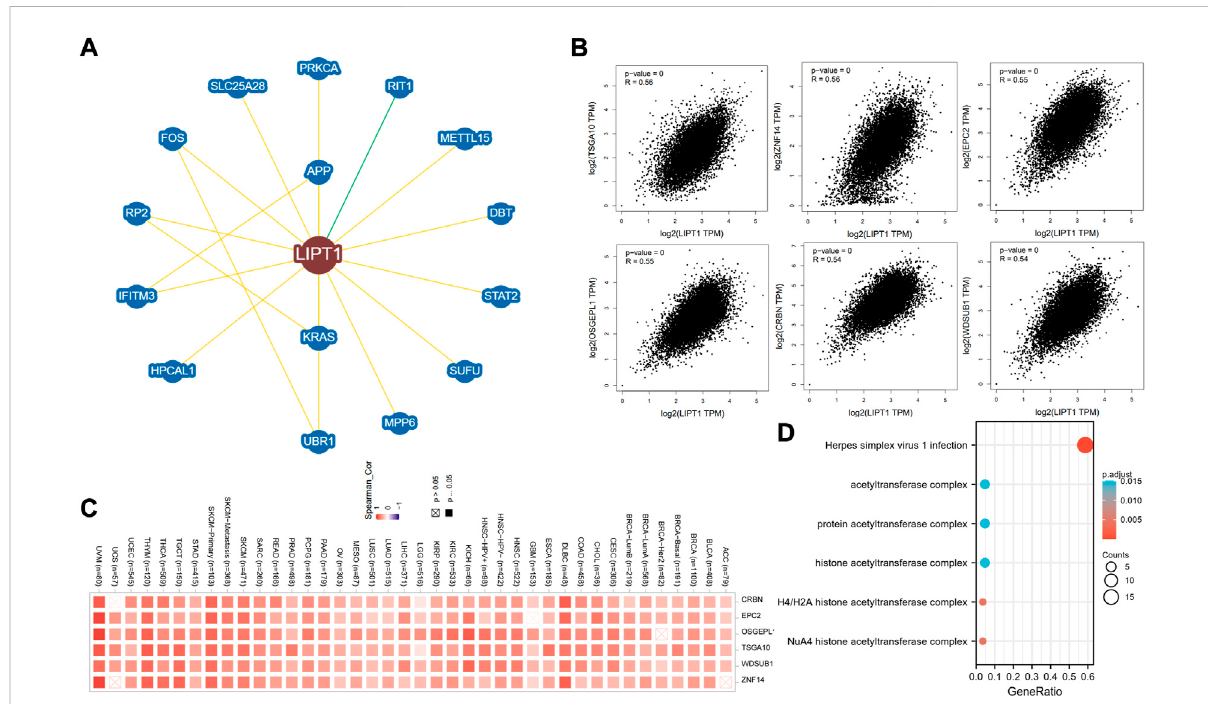
FIGURE 8 FunctionalenrichmentanalysisofLIPT1-relatedgenes. (A) LIPT1-relatedgeneswereobtainedfromtheBioGRIDwebtool,and15proteinswere displayed. (B) GEPIA2.0 showed the positive correlations between LIPT1 and six genes (TSGA10, ZNF14, EPC2, OSGEPL1, CRBN, and WDSUB1). p -value < 0.001. (C) The heatmap con fi rmed that LIPT1 expression was positively correlated with the six genes (TSGA10, ZNF14, EPC2, OSGEPL1, CRBN, and WDSUB1) in pan-cancer. (D) GO and KEGG enrichment analyses of LIPT1-related